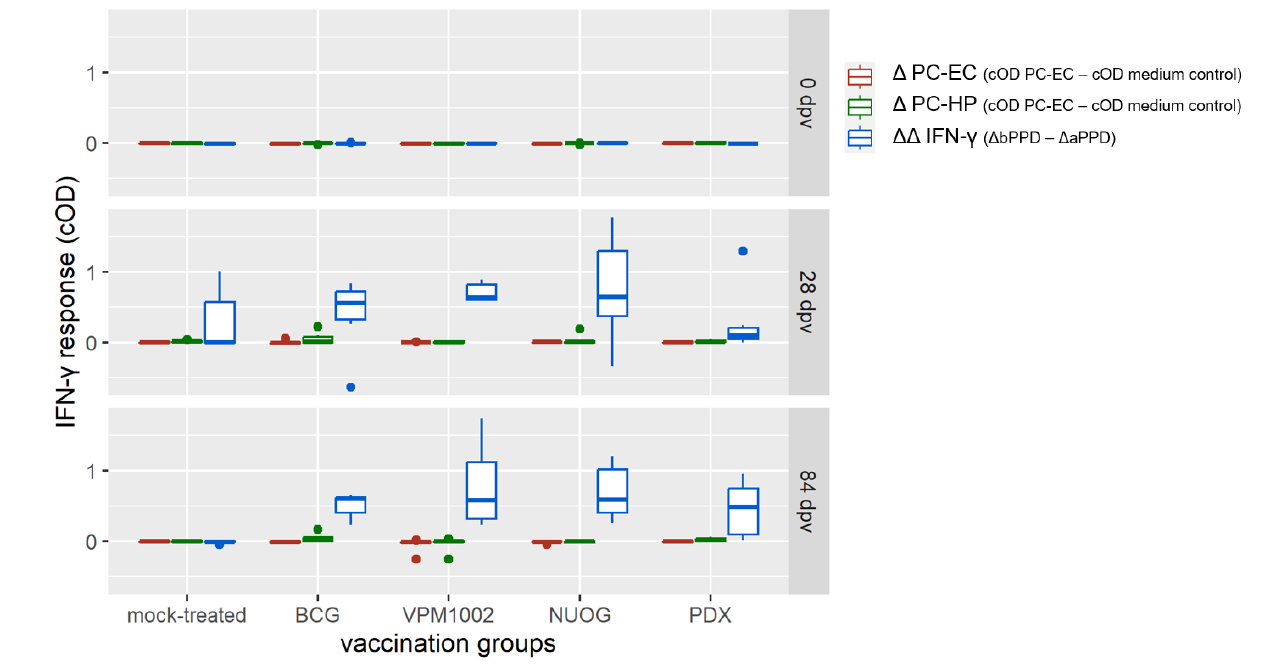
Figure 6. Interferon gamma (IFN- γ ) release following stimulation with Mycobacterium (M.) bovis - specific peptide cocktails Bovigam ® PC-EC and PC-HP (Prionics Lelystad B.V.) of whole blood samples of BCG-, VPM1002-, NUOG-, or PDX-vaccinated and mock-treated goats. Data is presented as ∆ IFN- γ values obtained after stimulation of blood samples taken at 84 dpv with PC-EC and PC-HP (cOD–cOD medium control) or with bovine and avian purified protein derivative (bPPD, aPPD, ∆∆ IFN- γ ), as described in Section 4.